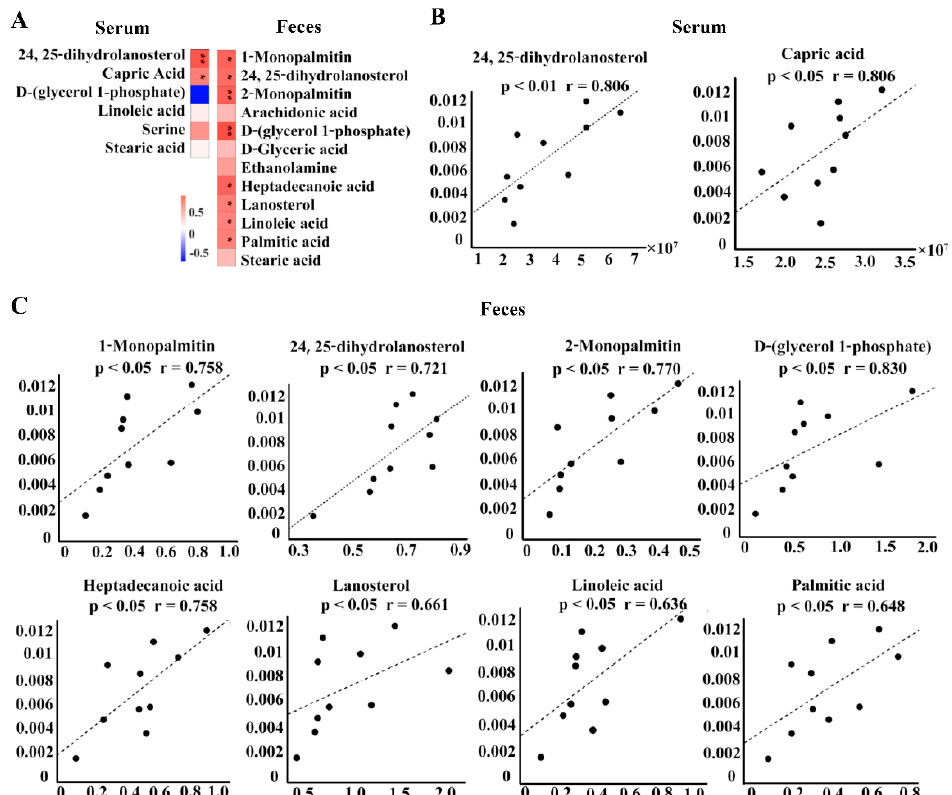
Figure 3. Spearman’s correlation results ( A ) and the corresponding scatter plots ( B , C ) showing the associations of intestinal Erysipelotrichaceae family with the metabolites related to lipid metabolism in serum and feces. Vertical coordinates are the relative abundance of Erysipelotrichaceae (%), and horizontal coordinates are the intensities of metabolites after correction ( C ). * p < 0.05, ** p < 0.01.